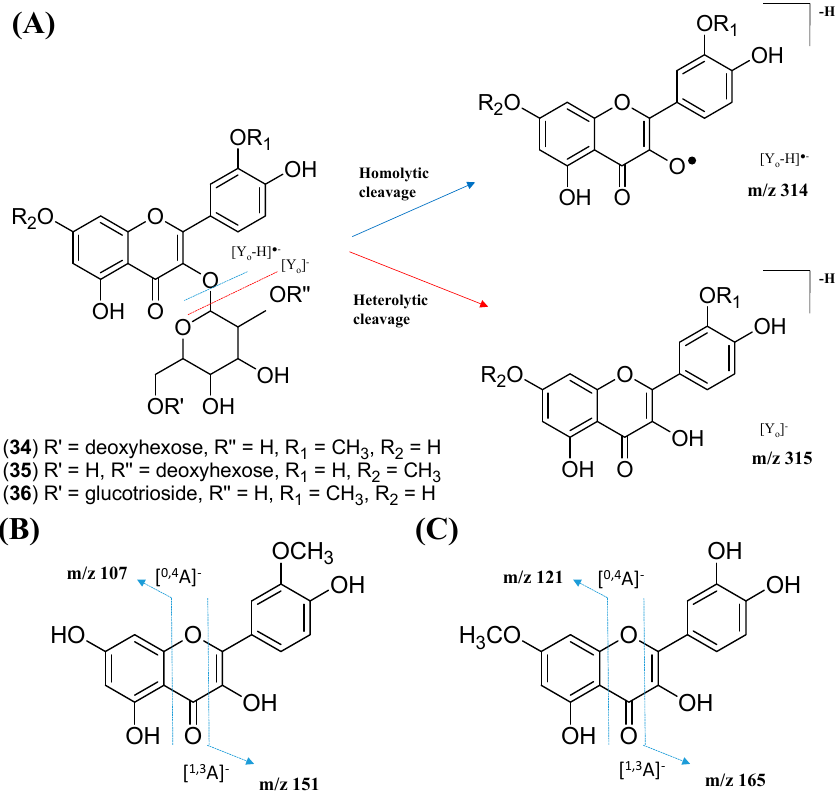
Figure 13. Proposed fragmentation mechanism in the MS/MS spectra recorded for the ( A ) mono- methoxyl group in negative ion mode of ( B ) isorhamnetin and ( C )